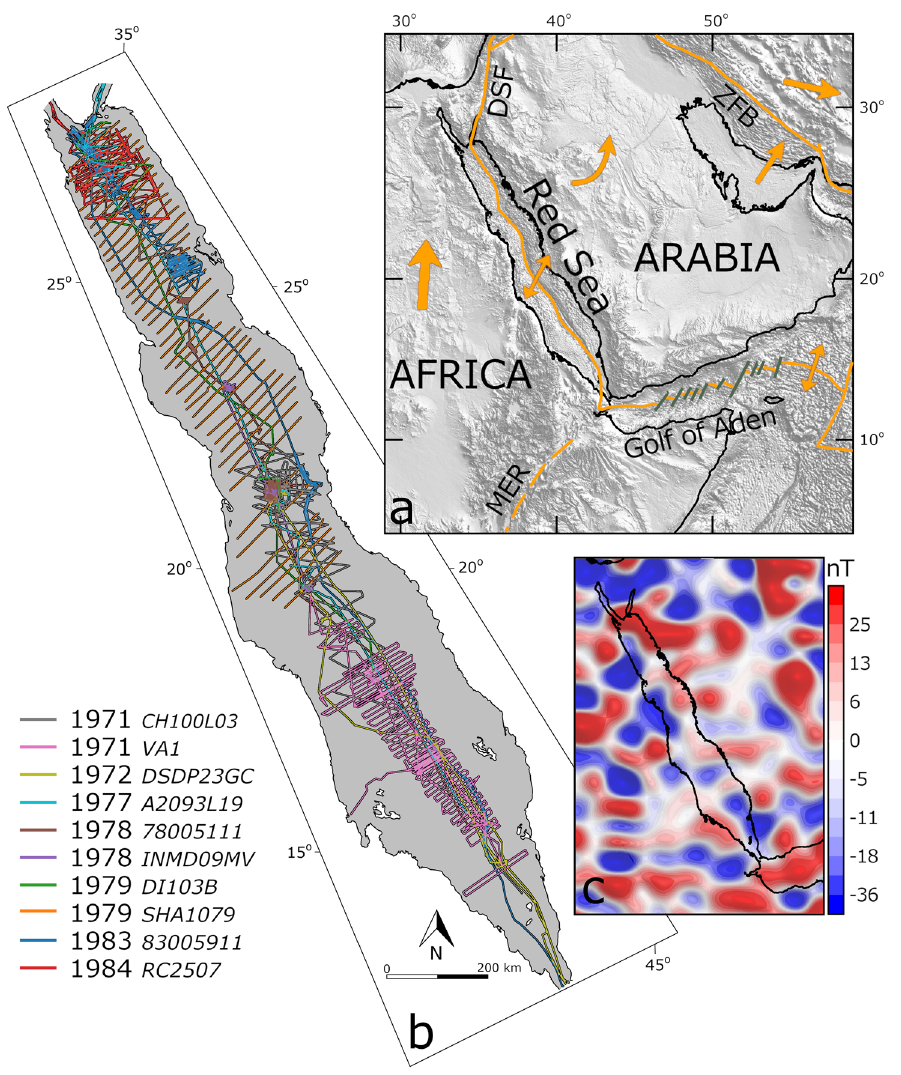
Figure 1. ( a ) Shaded relief map and regional tectonic settings (after Stern and Johnson, 2010) 72 of the Red Sea area. ( b ) Track lines data used in this study. ( c ) Total magnetic field anomaly from satellite derived magnetic model,